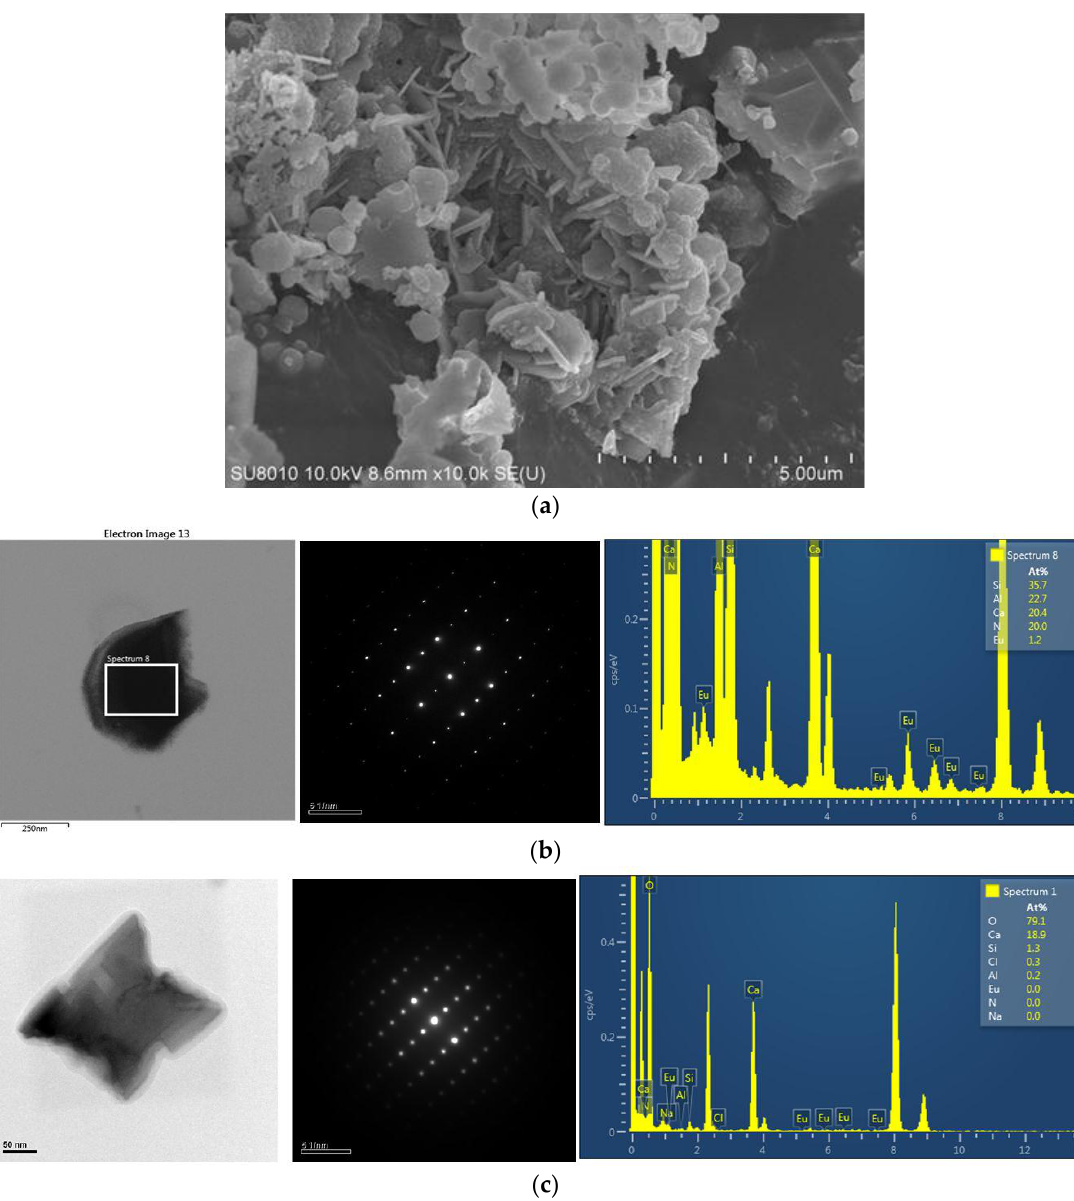
Figure 9. SEM and TEM images, SAED patterns and element analysis of agglomerated fine particles synthesized with Ca:Al:Si:Si 3 N 4 :Eu 2 O 3 :NaN 3 :NH 4 Cl = 1.0:1.0:0.25:0.25:0.02:3.5:0.6. ( a ) SEM image of agglomerated fine particles; ( b ) TEM image, SAED pattern and element analysis of an agglomerated fine particle (showing it to be CaSiAlN 3 :Eu 2+ ); ( c ) TEM image, SAED pattern and element analysis of an agglomerated fine particle (showing it to be CaO).